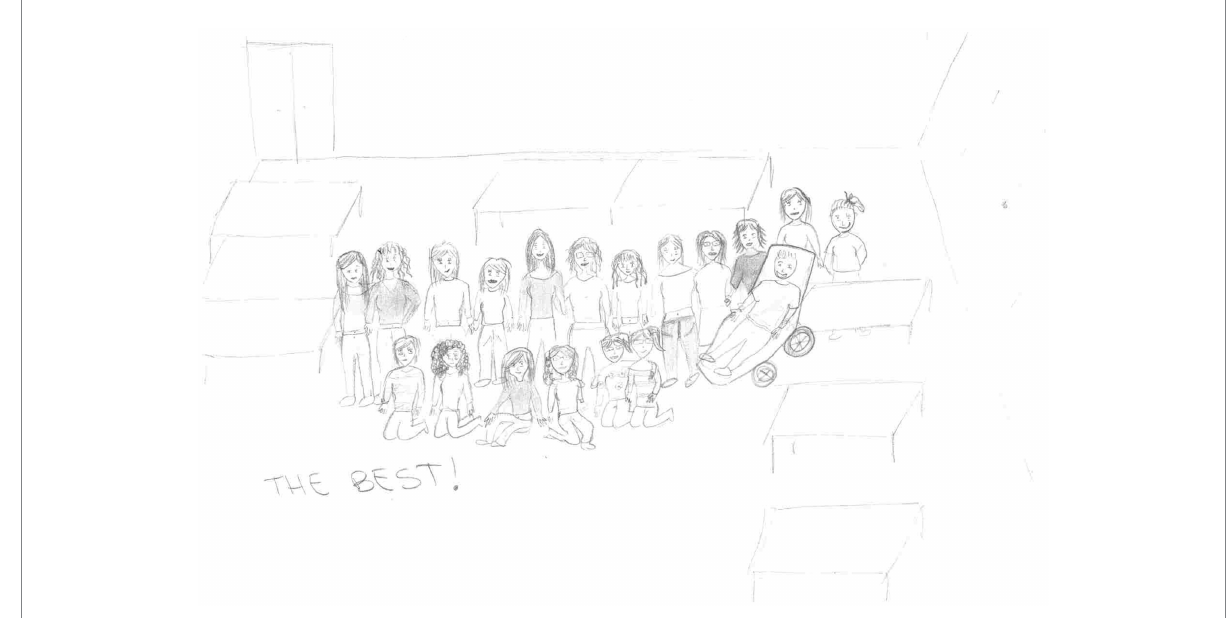
FIGURE 6 Classroom drawing: Group class and teachers. The drawer, the classmates, and the teacher. Integration 3. Female, 12 years old.